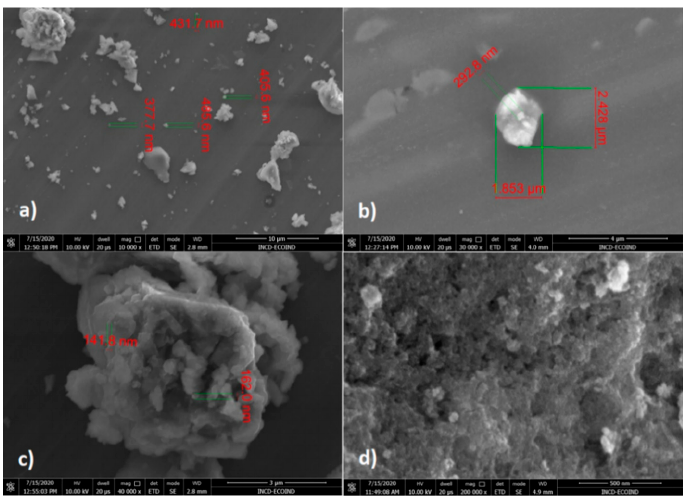
Figure 6. SEM images of CoFe 2 O 4 at different magnifications: ( a ) 10.000×, ( b ) 30.000×, ( c ) 40.000×, ( d ) 200.000×.